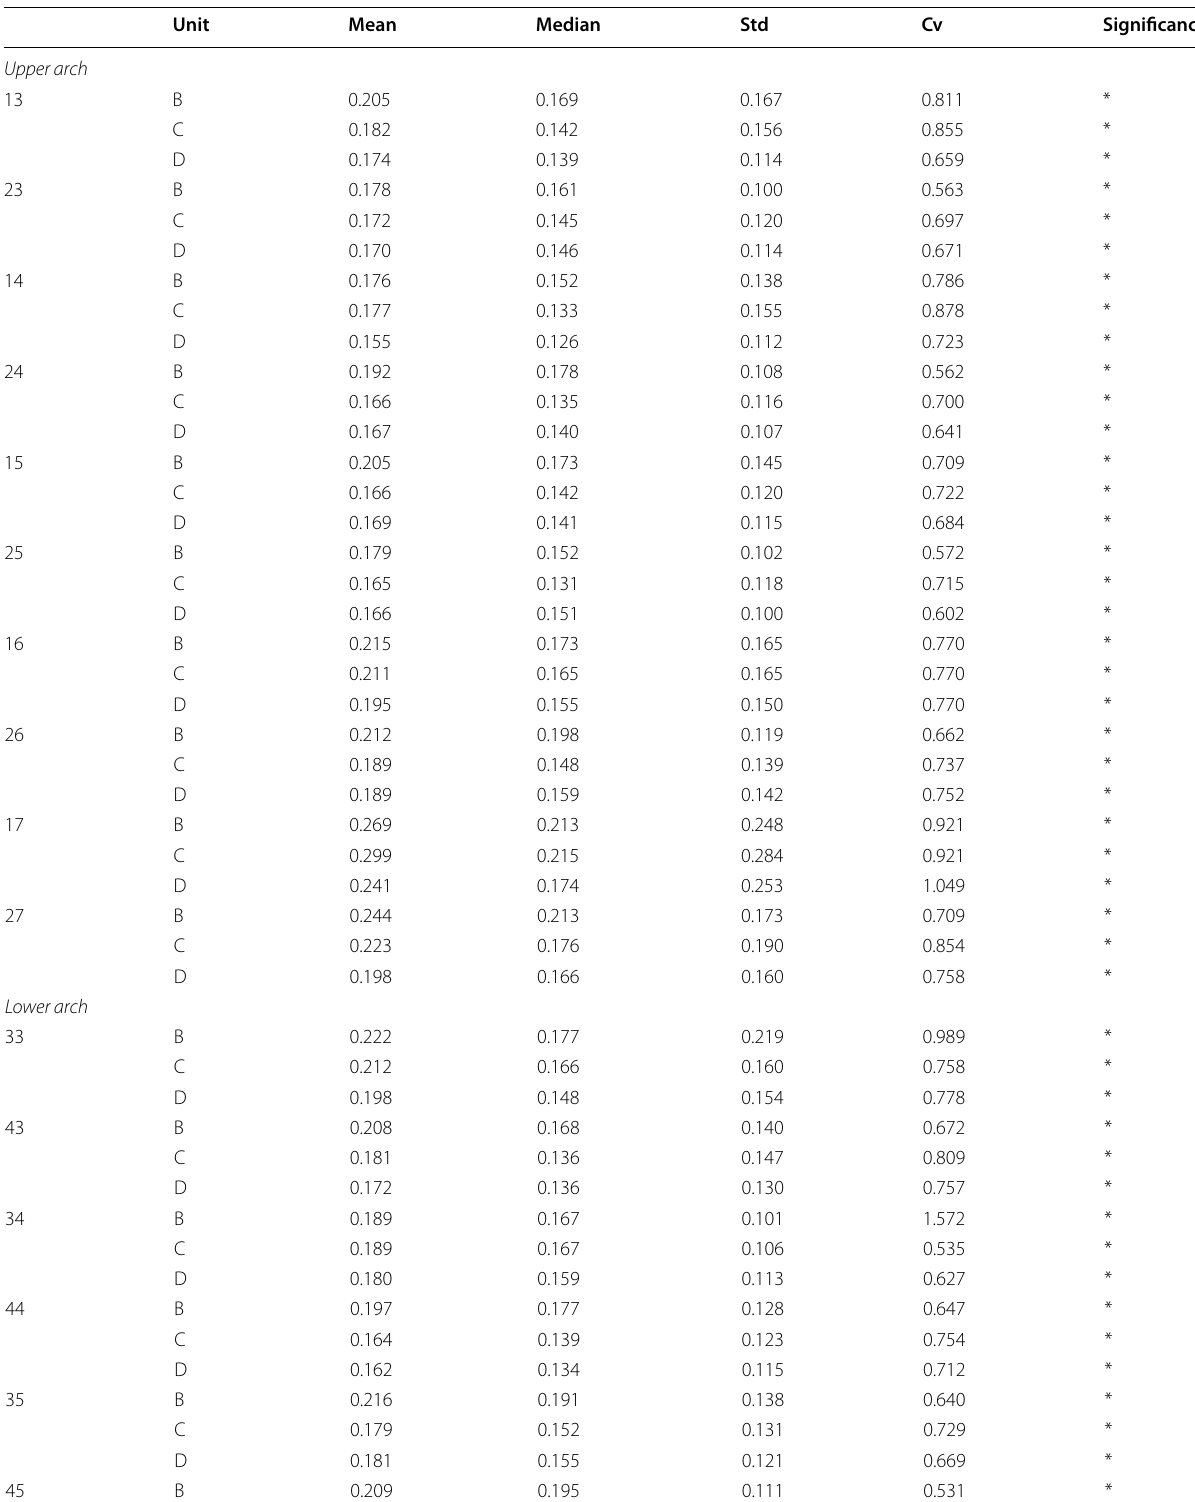
Table 4 Reproducibility of linear measurements (mm) of STL files between PVS impression (unit A) and unit B (Carestream CS 3600), unit C (CEREC Omnicam) and unit D (Trios